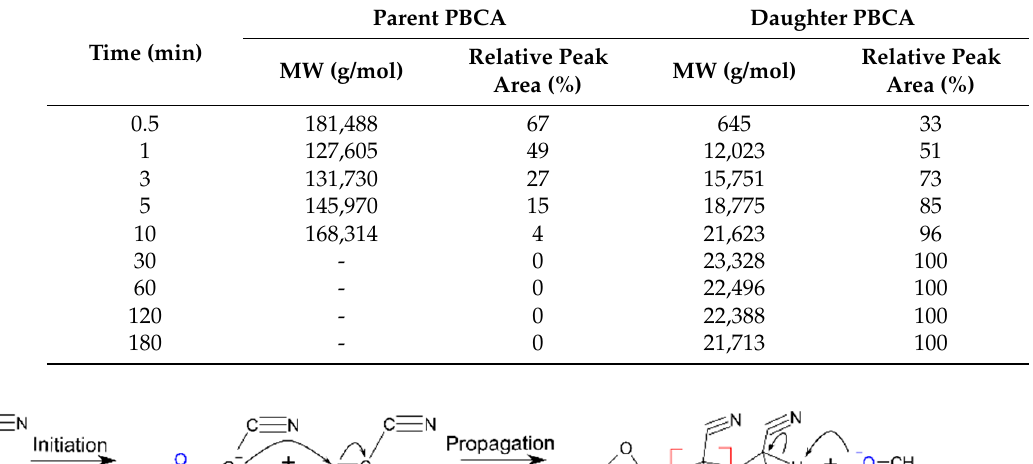
Table 2. MW and relative peak area of parent and daughter PBCA as determined by APC™ (653 mM BCA, 1 mM TFA and 8 mM NaOMe).